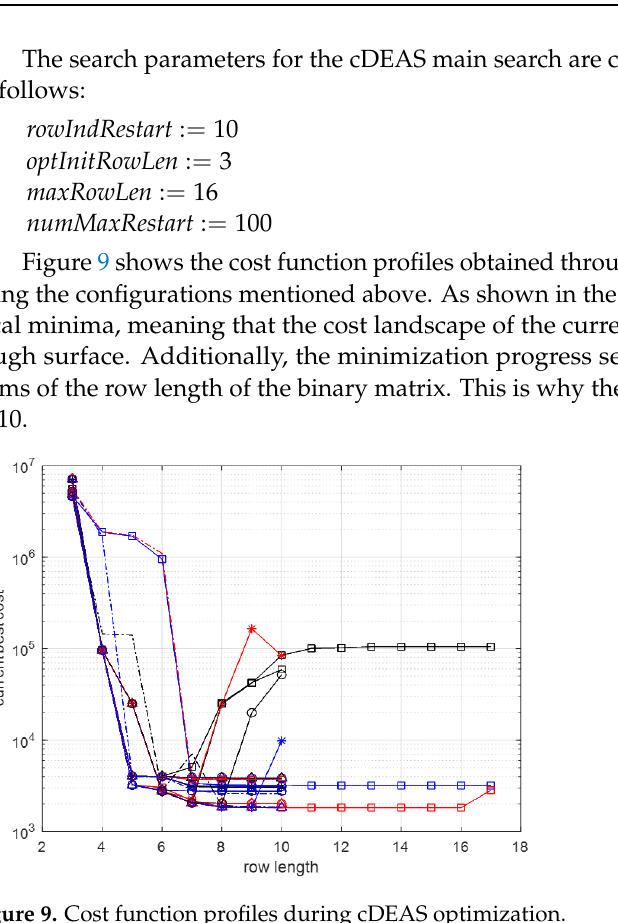
Figure 9. Cost function profiles during cDEAS